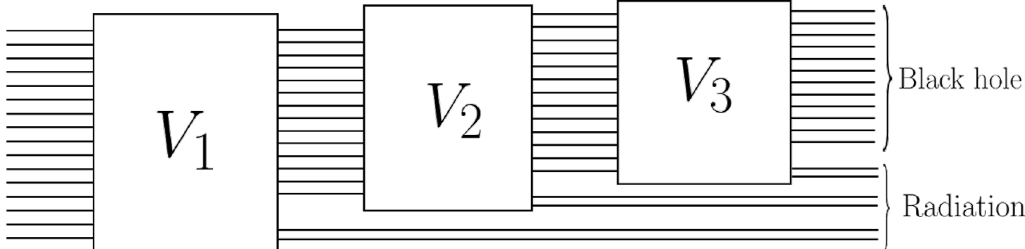
Figure 9. A simple toy model of black hole evaporation that takes into account the increase in thermodynamic entropy as the black holes evaporates. At each timestep, two qubits escape the black hole as Hawking radiation, but then a random isometry is applied to the black hole that increases the number of qubits by one. The total number of qubits (corresponding to the total thermodynamic entropy) therefore increases by one qubit at each timestep. Even if we collect the radiation qubits until long after the Page time, qubits that are radiated only a few timesteps into the future will be completely unentangled with the radiation that we have